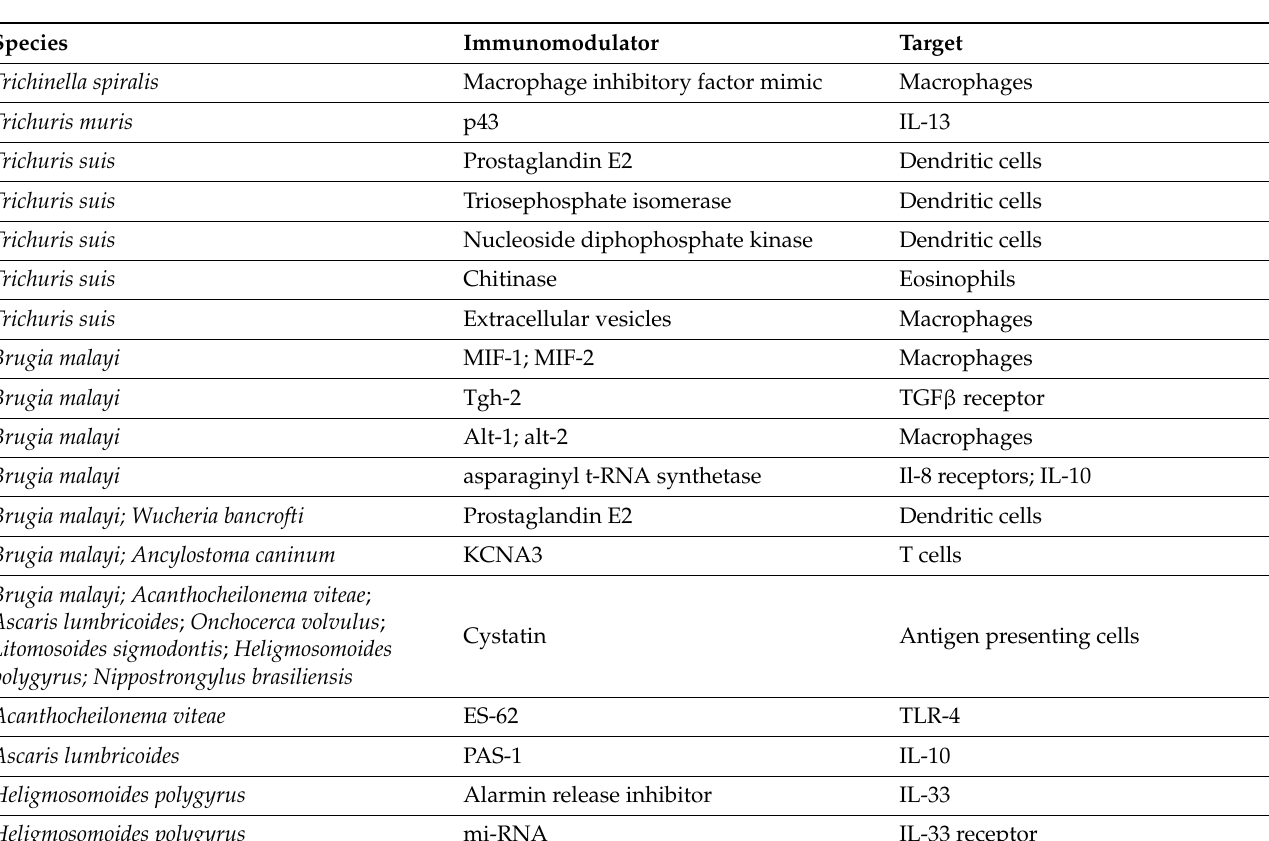
Table 1. Nematode-derived immunomodulators listed by species and by molecular or cellular target. References and further details are provided in the